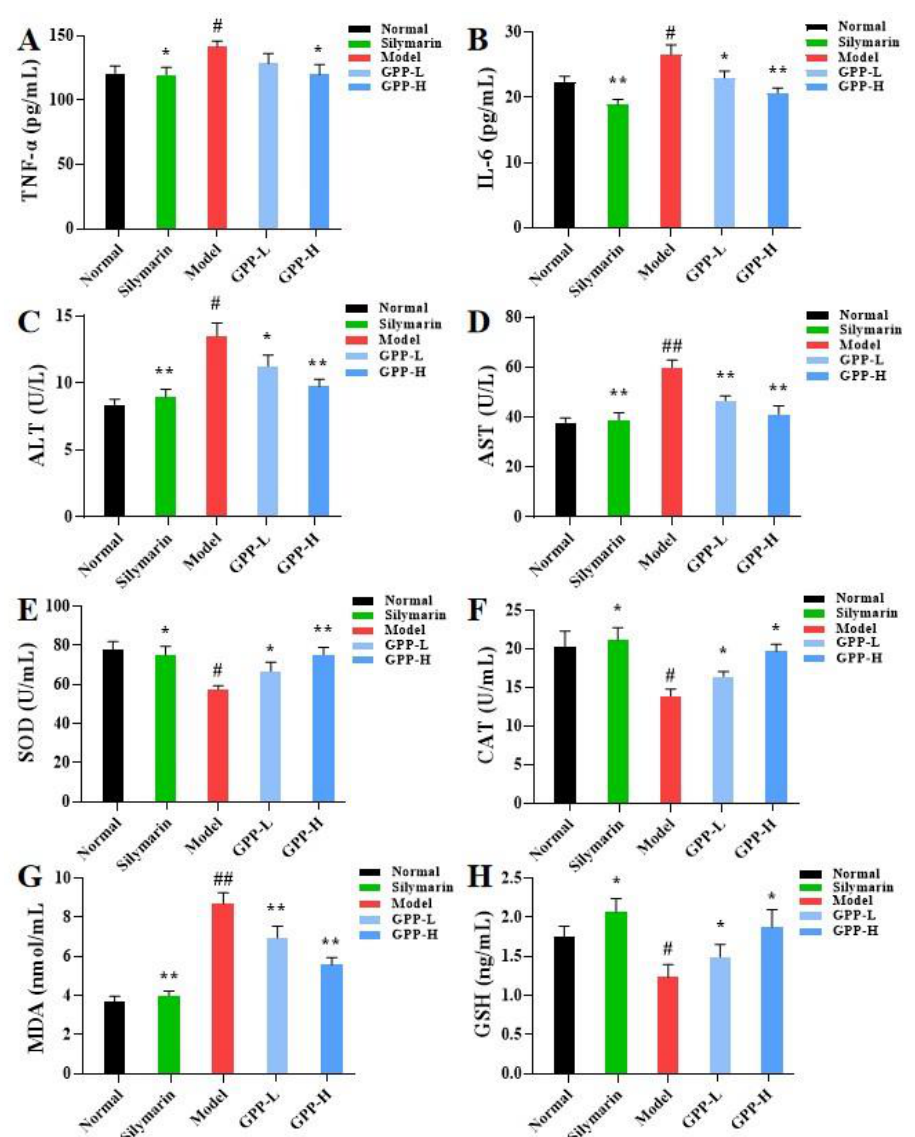
Figure 4. ( A , B ) The secretion of inflammatory cytokines (TNF- α and IL-6), ( C – H ) enzyme activity (ALT, AST, SOD, CAT and GSH) and lipid metabolite contents (MDA) in mice were measured. SOD, CAT, MDA and GSH in liver tissues were measured. Compared with the model group, * in the same column indicates significant difference ( p < 0.05). Compared with the normal group, # means significant difference ( p < 0.05). Values are presented as means ± SDs ( n = 3).